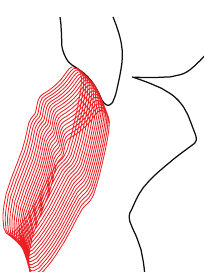
Figure 6: Simplified case: envelope of the incisors when motion is constrained by contact between the incisal pin and the novel incisal table featuring uniform-curvature.